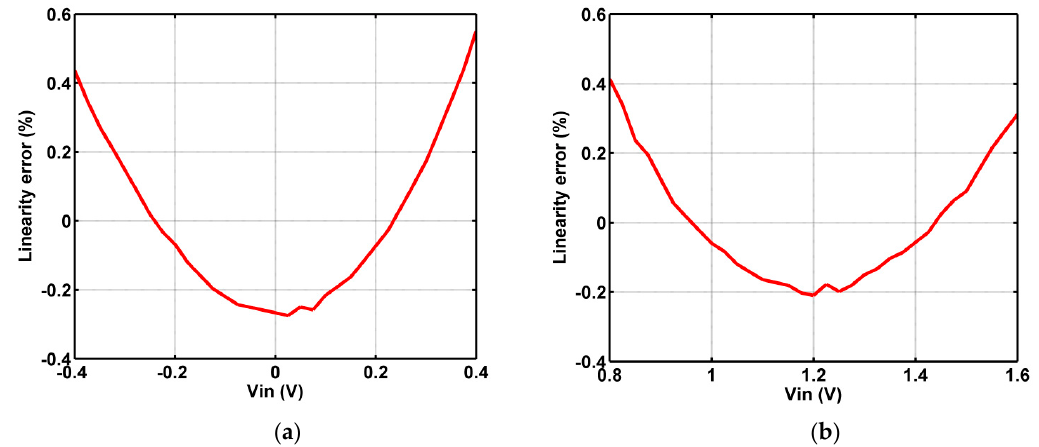
Figure 10. ( a ) Linearity error percentage for the first proposed VTC. ( b ) Linearity error percentage for the second proposed VTC.